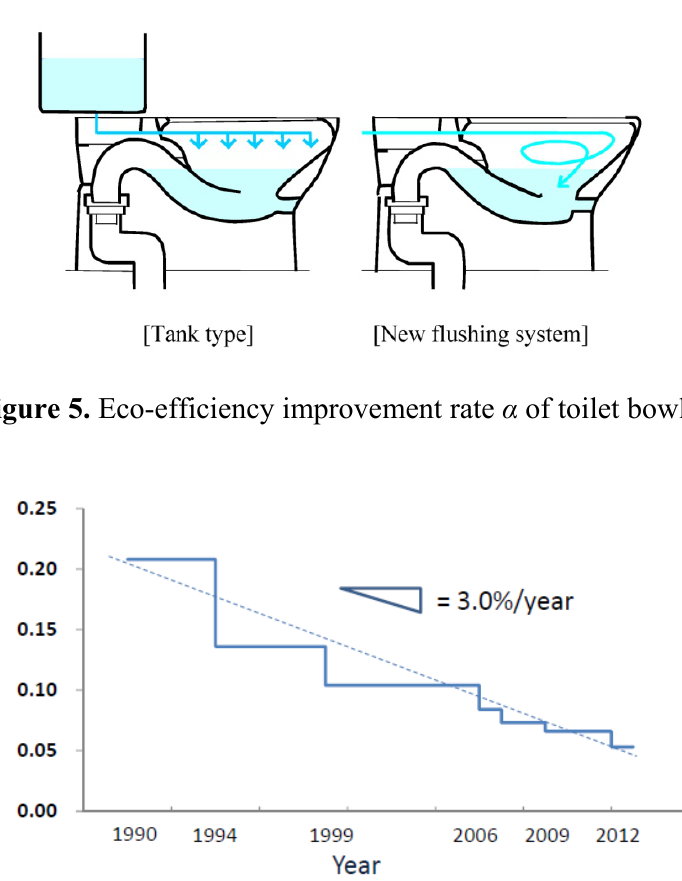
Figure 4. Toilet bowl flushing types.